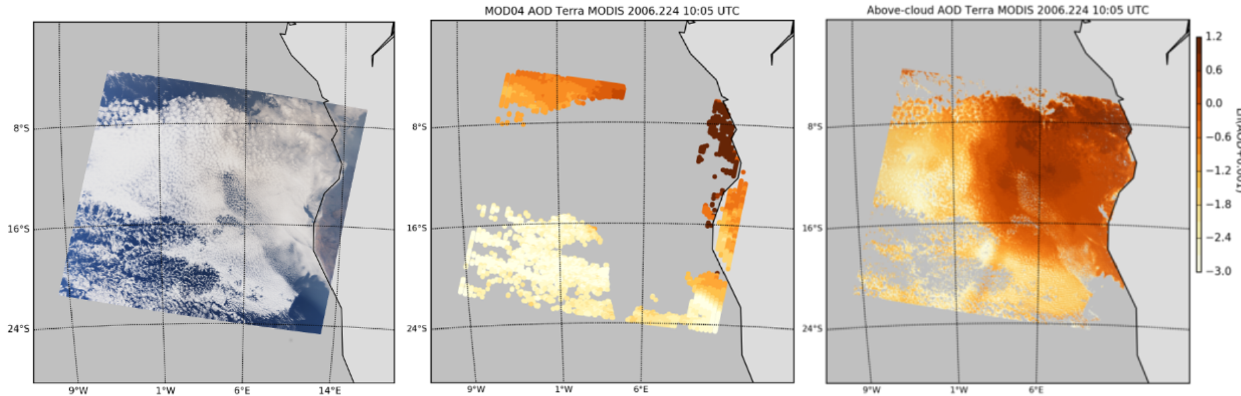
Figure 2. Real-data example of MOD06ACAERO retrieval. Terra MODIS 2006 day 224 10:05UTC. Panel (a) shows the true-color MODIS granule. There is extensive aerosol layer above the equally extensive MBL cloud layer. Panel (b) shows the MODIS Data Collection 6 operational Dark Target aerosol retrieval. It is a 10km resolution product with retrievals available only in clear-sky conditions and outside glint. Panel (c) shows the MOD06ACAERO above-cloud aerosol retrieval that is able to fill the data gap created by presence of